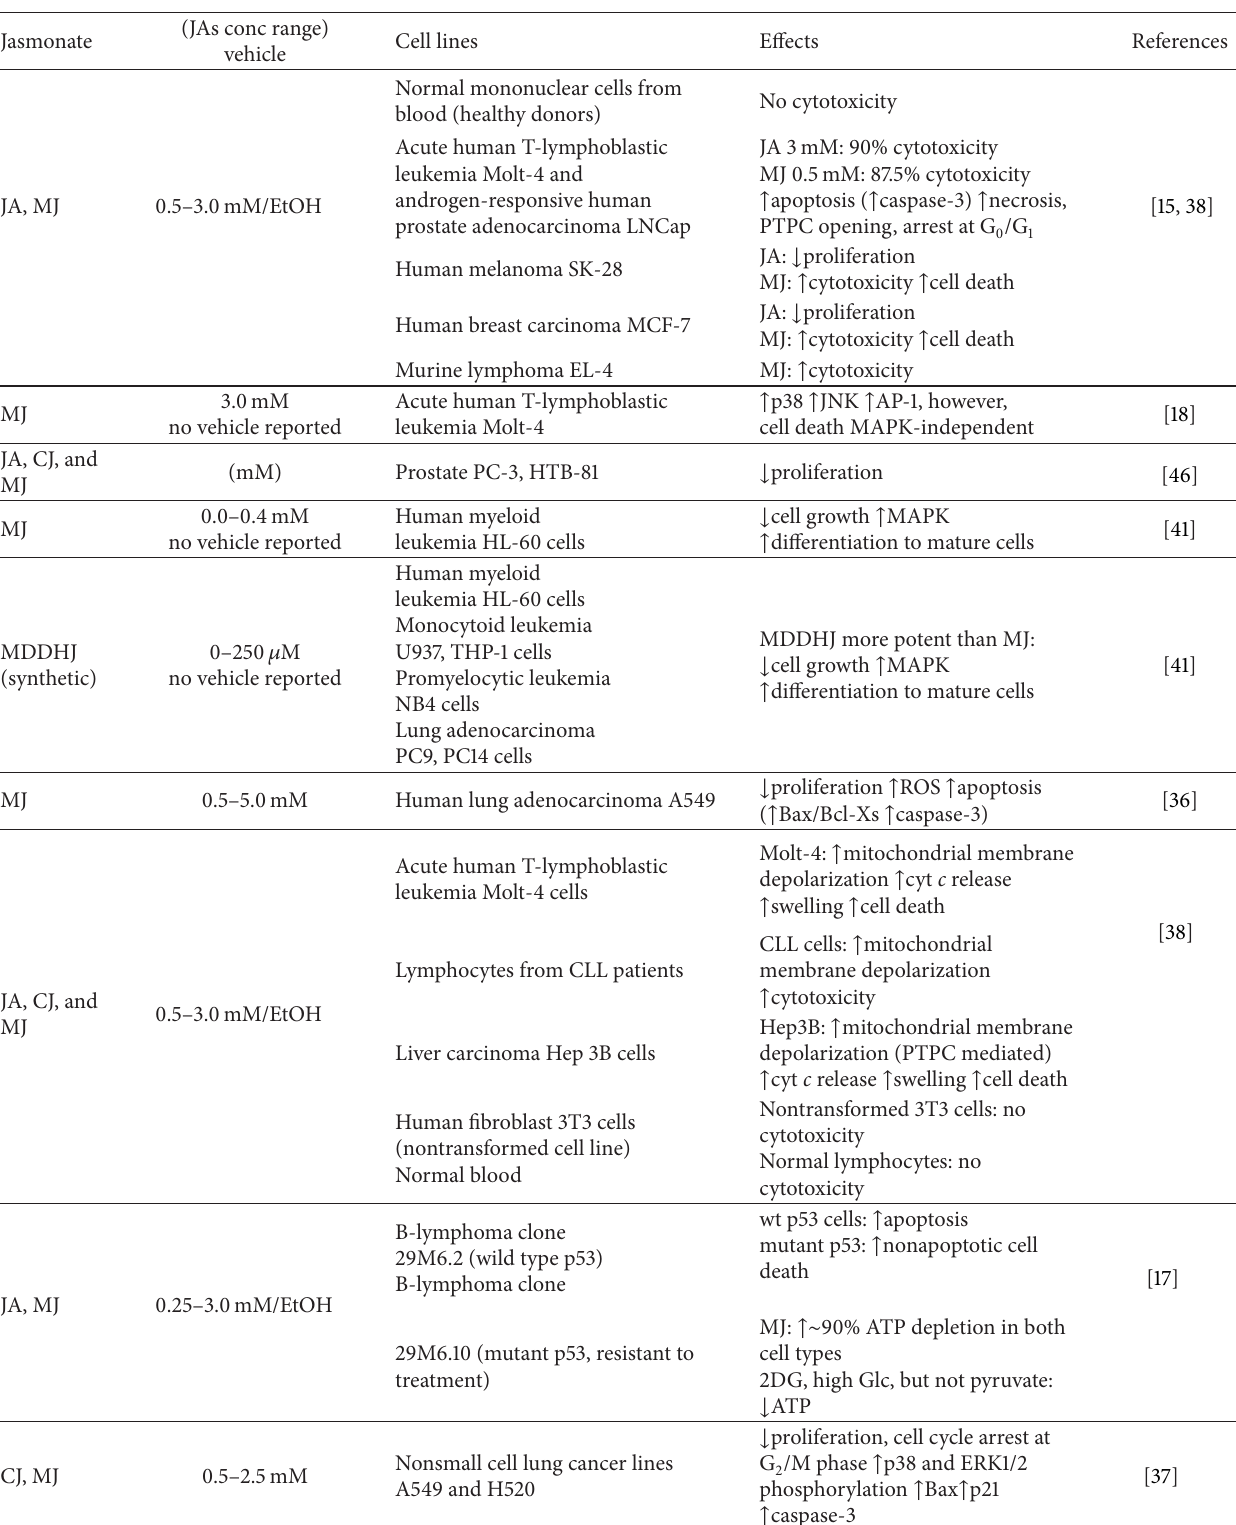
Table 1: Effect in vitro of natural and synthetic jasmonates on normal and cancer